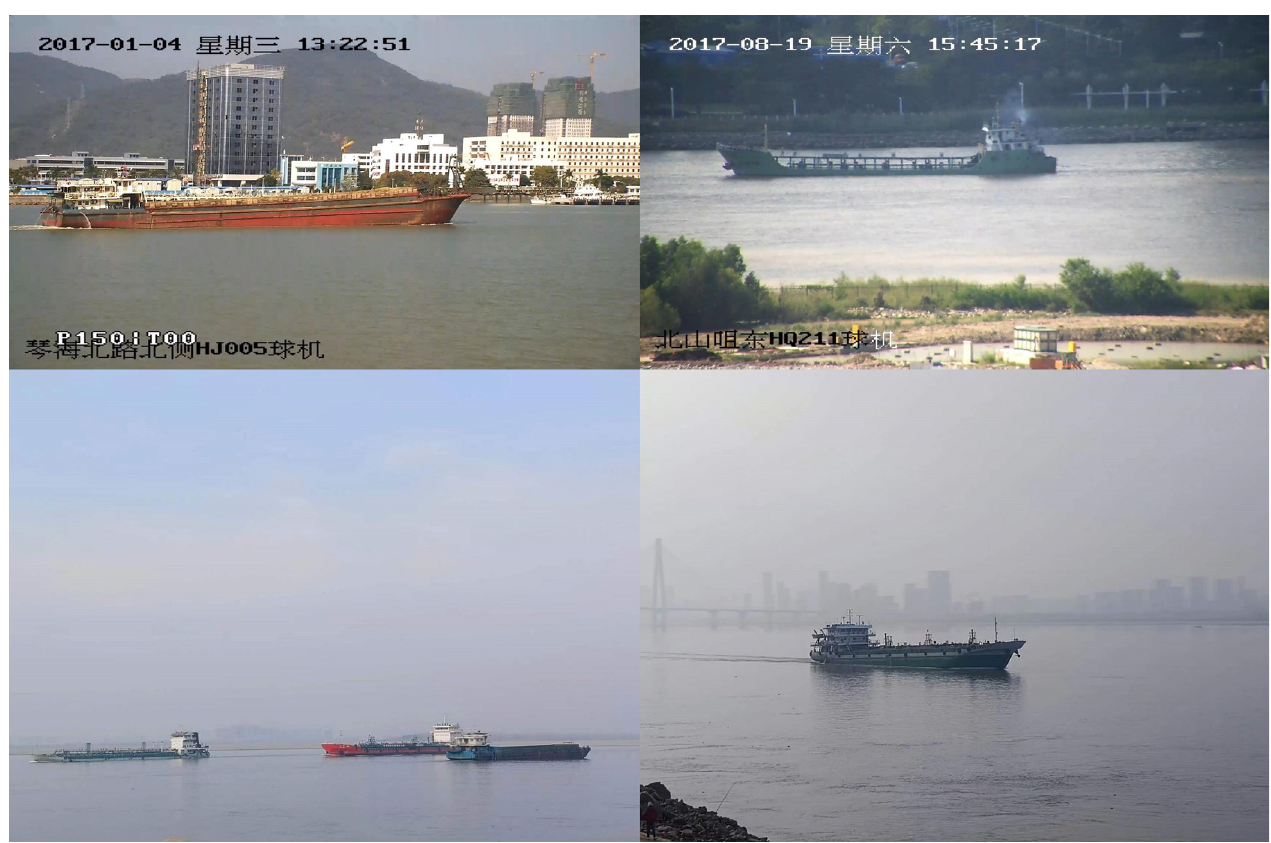
Fig 9. Example dataset. The first row is an example of an image from the SeaShips dataset. The second row is an example of the images collected for this experiment.